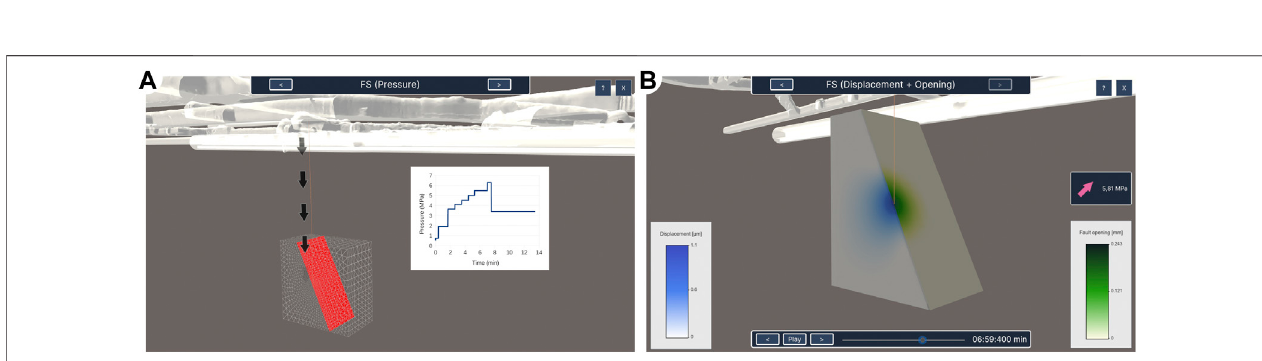
FIGURE11| Twovisualisations oftheFault SlipExperiment (A) ageneral illustration oftheexperiment and (B) simulation resultswithan additionalarrow indicating the change of pressure relative to the last time step.